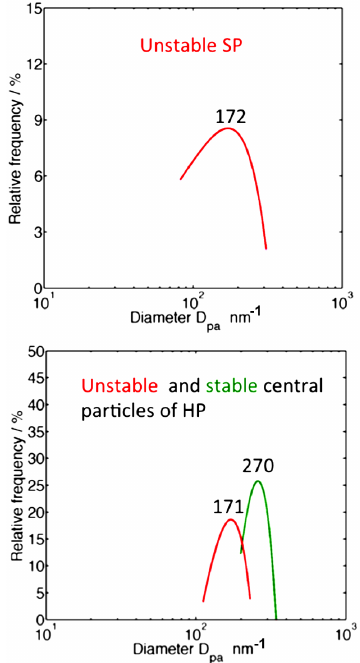
Figure 6. Number size distributions obtained from TEM images. Upper panel shows unstable SP while the lower panel exhibits cen- tral particles of HP. The red line represents the unstable central par- ticles, while the green line represents the stable central particles comprising “aggregate”, “aggregate with film”, and skeletal parti-